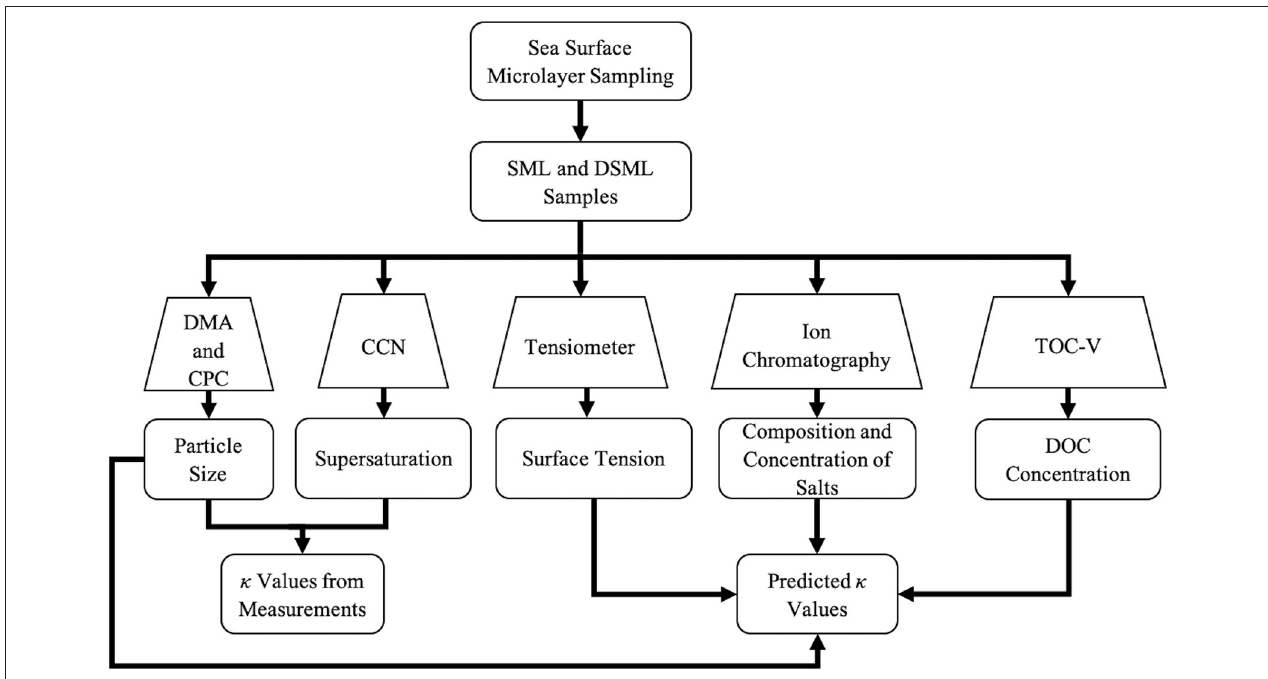
FIGURE 3 | Flow chart for analysis to determine κ values from measurements and predicted κ values. The trapezoids and rectangles indicate the instrumentation or analysis technique used and the information collected from the specified methods, respectively.